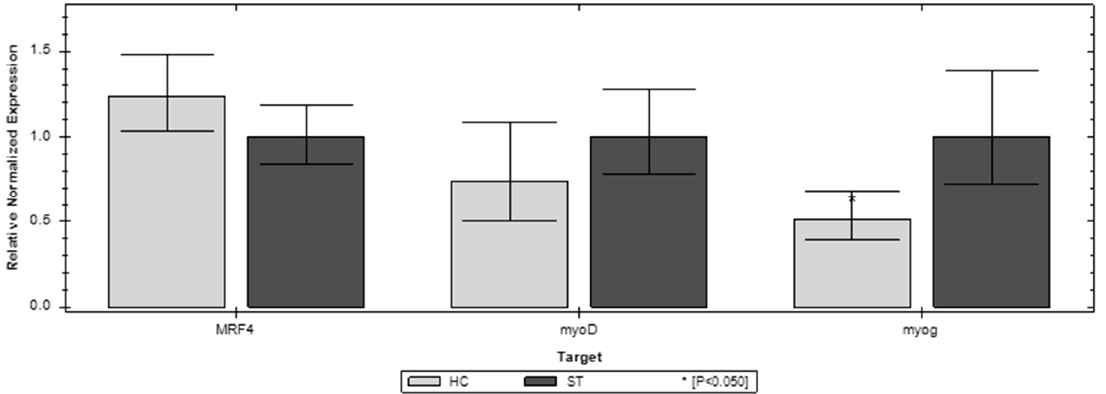
Figure 4. Relative expression of the MFR4, myoD, and myoG genes on the 21 st day (D21) of life in the standard (ST) and HatchCare (HC) groups ( p = 0.261 for MRF4, p = 0.229 for myoD, and p = 0.008 for myog). Significant difference compared to ST (* p < 0.05). The figure was generated with CFX Maestro Software 2.3.